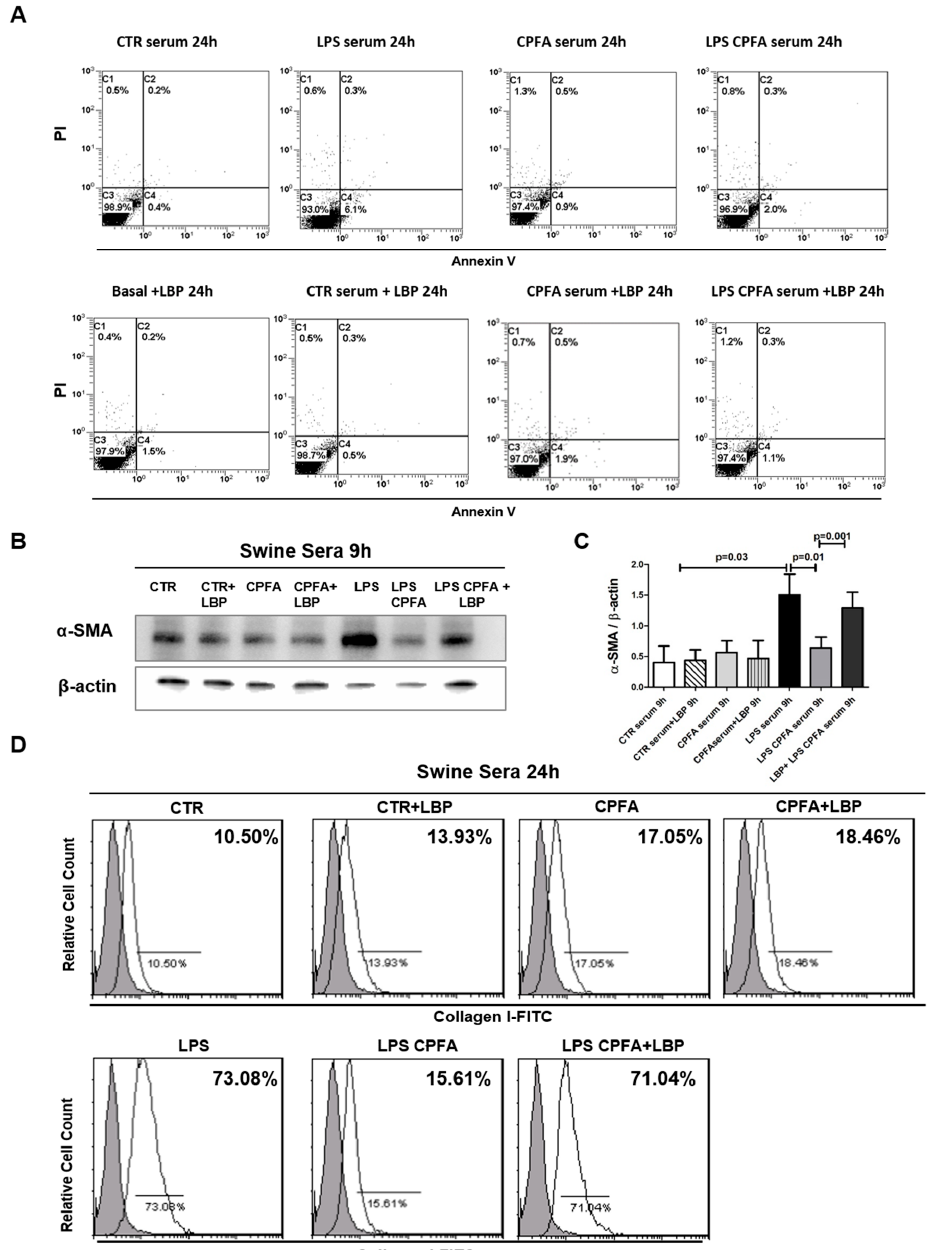
Figure 3. LBP was critical in LPS-mediated early PMT. Cultured pericytes were stimulated with LPS 4 µ g / Ml or LBP 9 µ g / Ml, or cultured in presence of di ff erent swine sera with / without LBP for the indicated time period. ( A ) Pericyte viability was evaluated by flow cytometry analysis (AnnV / PI). Cells did not undergo apoptosis. ( B , C ) WB analysis revealed a significant increase of α -SMA expression after 9 h of endotoxemic sera incubation. CPFA-treated septic sera (LPS CPFA) maintained the expression of α -SMA at low level as CPFA-treated healthy sera (CPFA group). Both in CTR and CPFA sera, the addition of exogenous LBP did not increase α -SMA expression. Remarkably, the addition of LBP in CPFA-treated endotoxemic sera (LPS CPFA) induced PMT like the untreated endotoxemic sera. β -actin protein expression was used for normalization. Data were shown as mean ± standard deviation (SD) and compared with the Student t test. ( D ) FACS (Fluorescence Activated Cell Sorting) showed a strong increase of Collagen I after 24 h of endotoxemic sera incubation compared to control. In accordance, CPFA-treated endotoxemic sera maintained Collagen I expression at basal level as CTR and CPFA group. Exogenous LBP supplementation in CTR and CPFA group did not stimulate Collagen I synthesis in pericytes. The LBP addition in LPS CPFA group completely reversed the e ff ects of CPFA treatment, leading to PMT. Results are representative of three independent